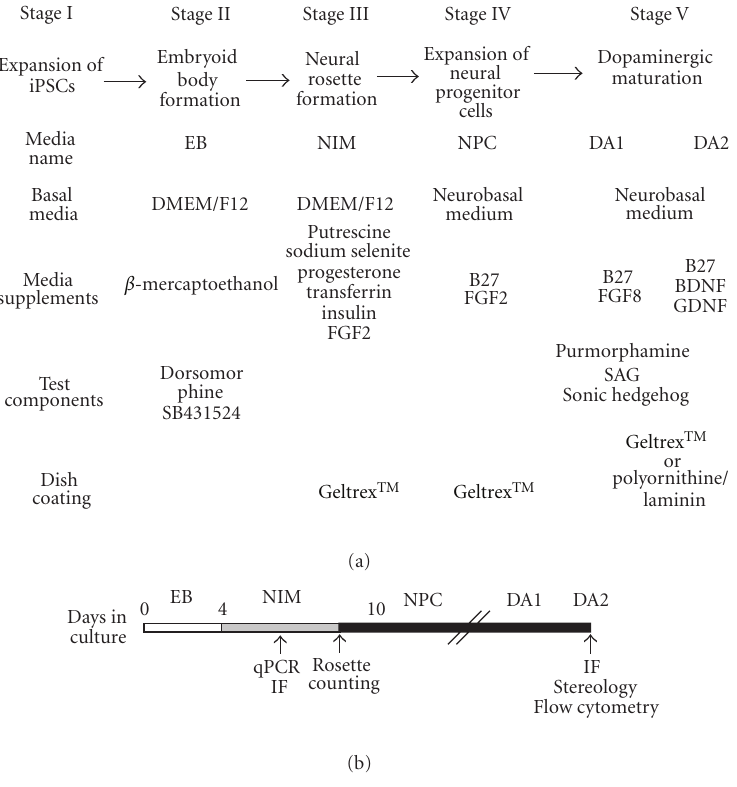
Figure 1: Schematic summary of the di ff erentiation conditions used in the generation of dopaminergic neurons (a) Schematic diagram illustrating the di ff erent stages of NPC generation and dopaminergic neuronal di ff erentiation. The abbreviations are. Dor/SB: Dorsomorphin and SB431542, EB: EB media, NIM: neural induction media, NPC: neural progenitor cell media, and DA1/DA2: medium for dopaminergic di ff erentiation. (b) Timeline shows the medium used at di ff erent stages of NPCs and dopaminergic maturation and displays the sampling dates for performing gene expression studies, such as qPCR, marker characterization (immunofluorescence: IF), to analyze e ffi ciency of rosette formation and for quantitative studies of TUJ1 and TH immunoreactivity using stereology and flow cytometry.